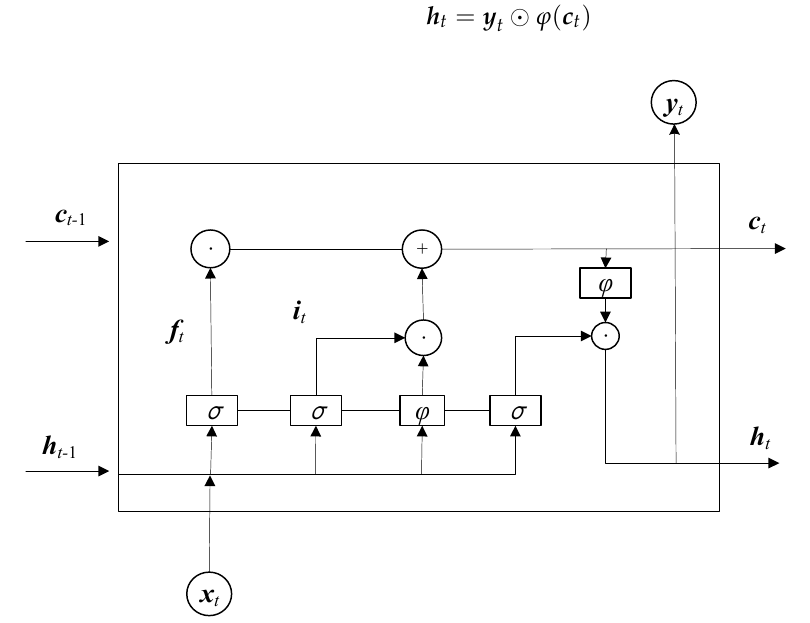
Figure 8. Diagram of LSTM neural networks.